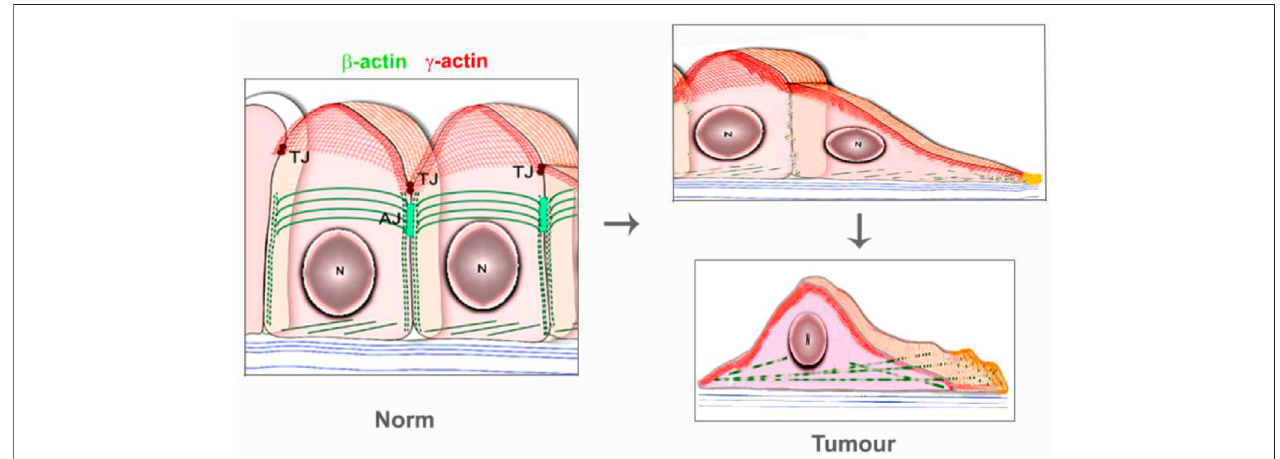
FIGURE 2 | Schema of actin isoform ’ s systems in the normal epithelial and carcinoma